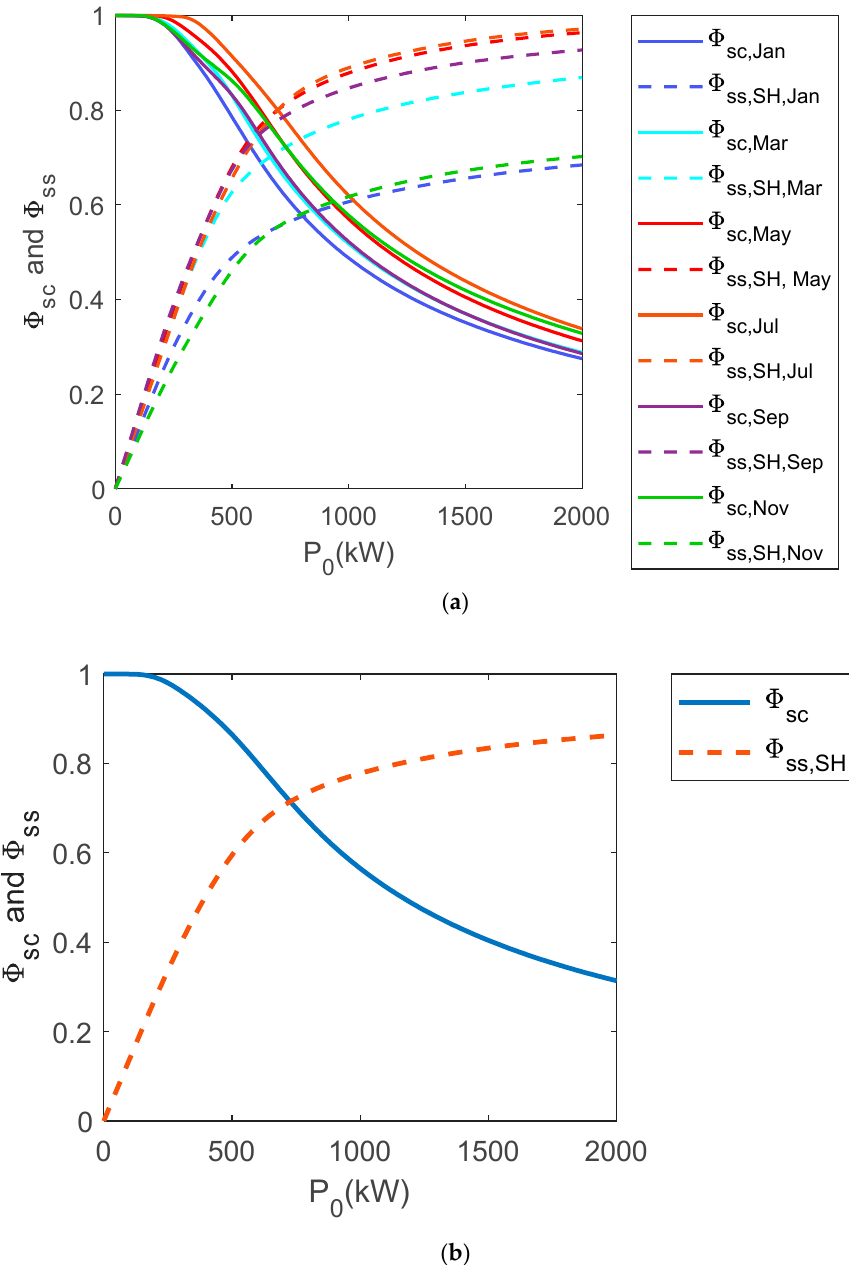
Figure 8. ( a ) Monthly self-consumption and self-sufficiency curves during sunshine hours; ( b ) Annual self-consumption and self-sufficiency curves during sunshine hours. Industry A